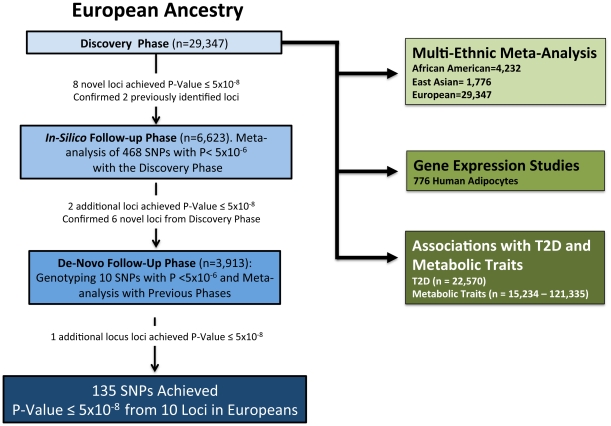
Flow chart of study design.